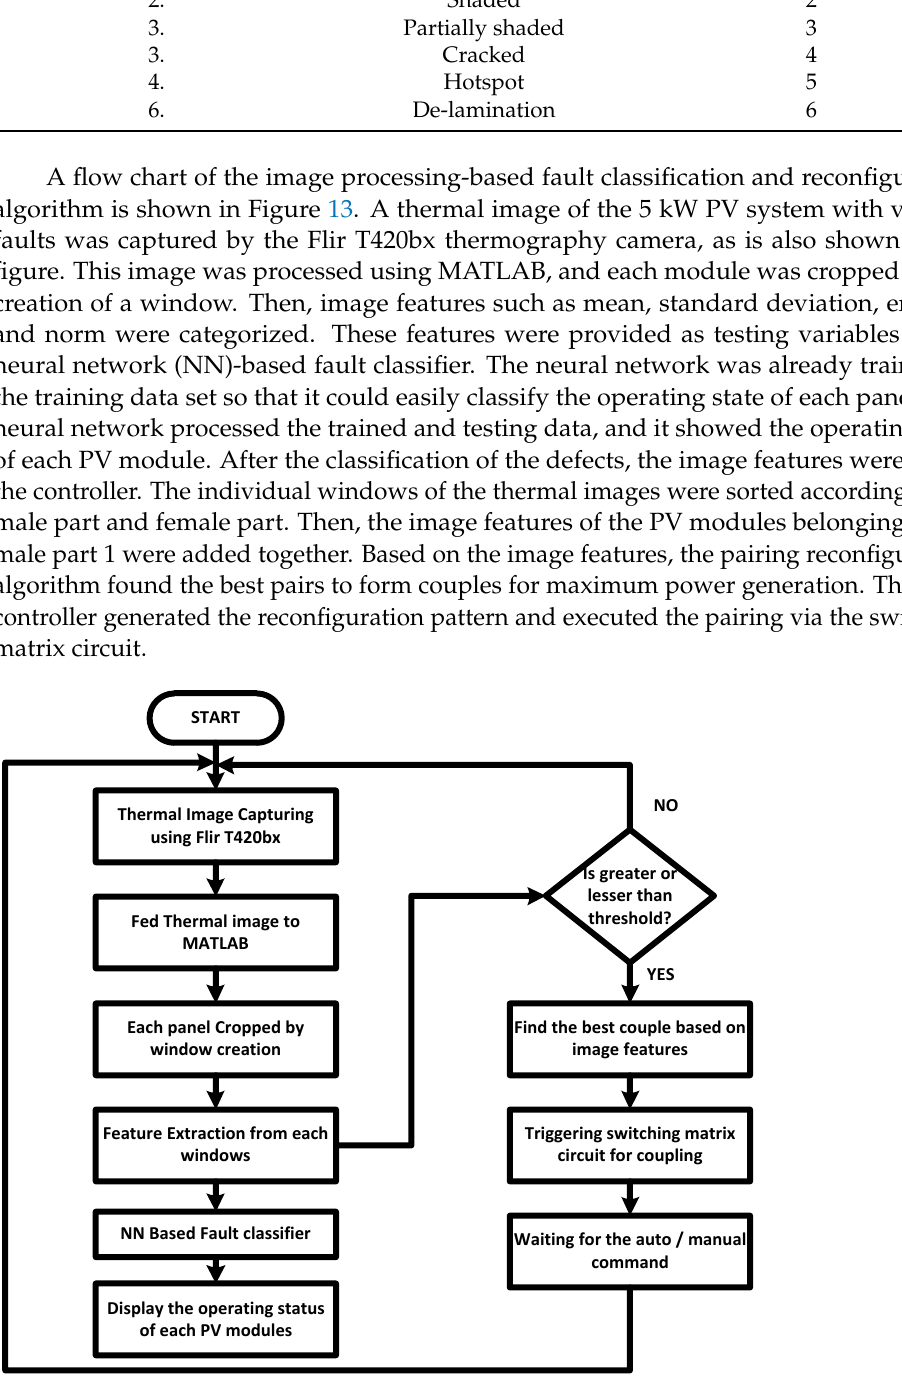
Figure 13. Flow chart of neural network-based fault classification with image processing-based re-